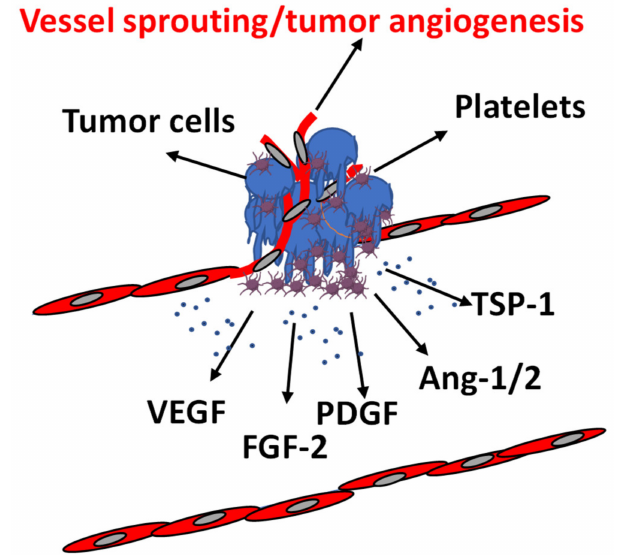
Figure 3. Association of platelets with tumor cells and endothelial cells in TME. Platelets in TME interact with both tumor cells and endothelial cells. Both cells affect platelets releasate and behavior. In TME, the release of platelet-related angiogenic factors promote tumor angiogenesis. VEGF: vascular endothelial growth factor; FGF-2: fibroblast growth factor-2; PDGF: platelet-derived growth factor; Ang1/2: angiopoietin 1/2; TSP-1: